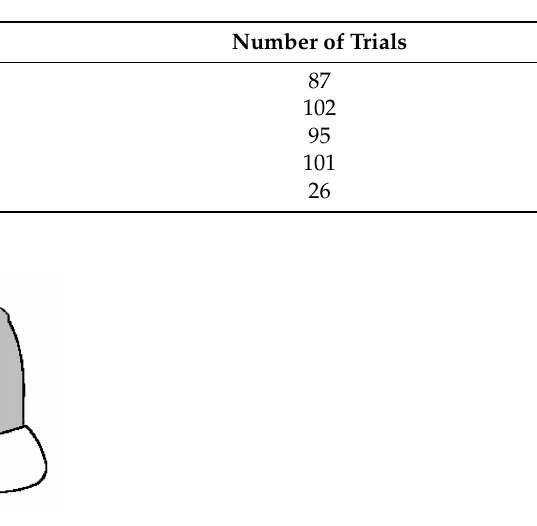
Table 2. Running speeds and number of collected trials.